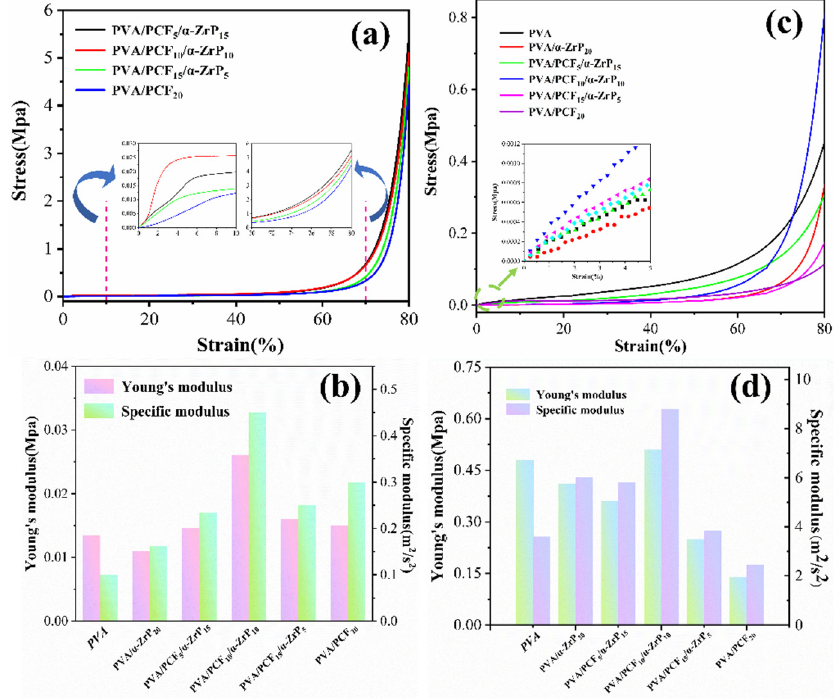
Figure 5. ( a ) vertically compressed stress-strain curves; ( b ) horizontally compressed stress-strain curves; ( c ) vertical Young’s modulus and specific modulus; ( d ) horizontal Young’s modulus and specific modulus.